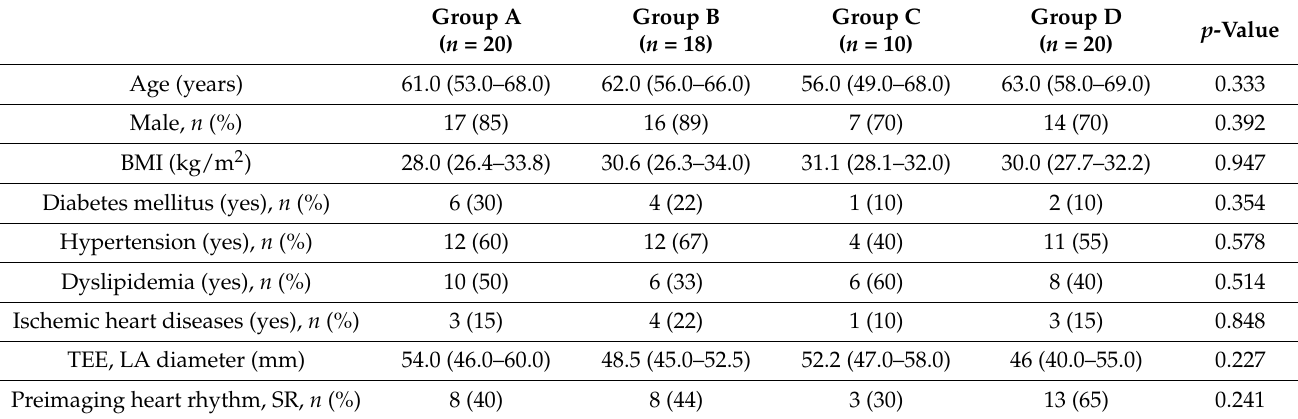
Table 1. Patient characteristics.